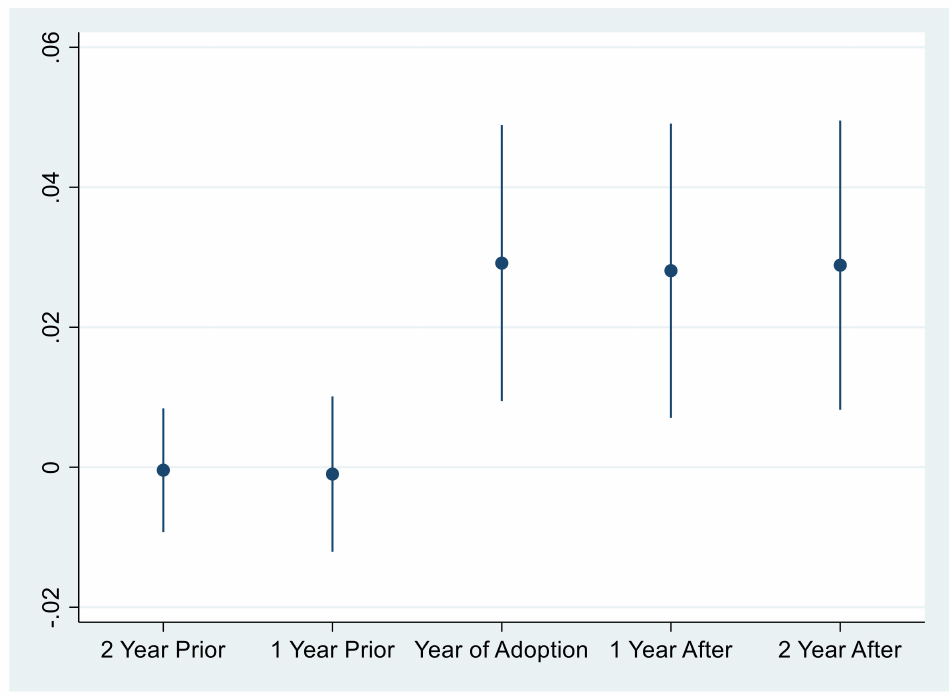
Figure 1. Box plot of parallel trend test (based on FE